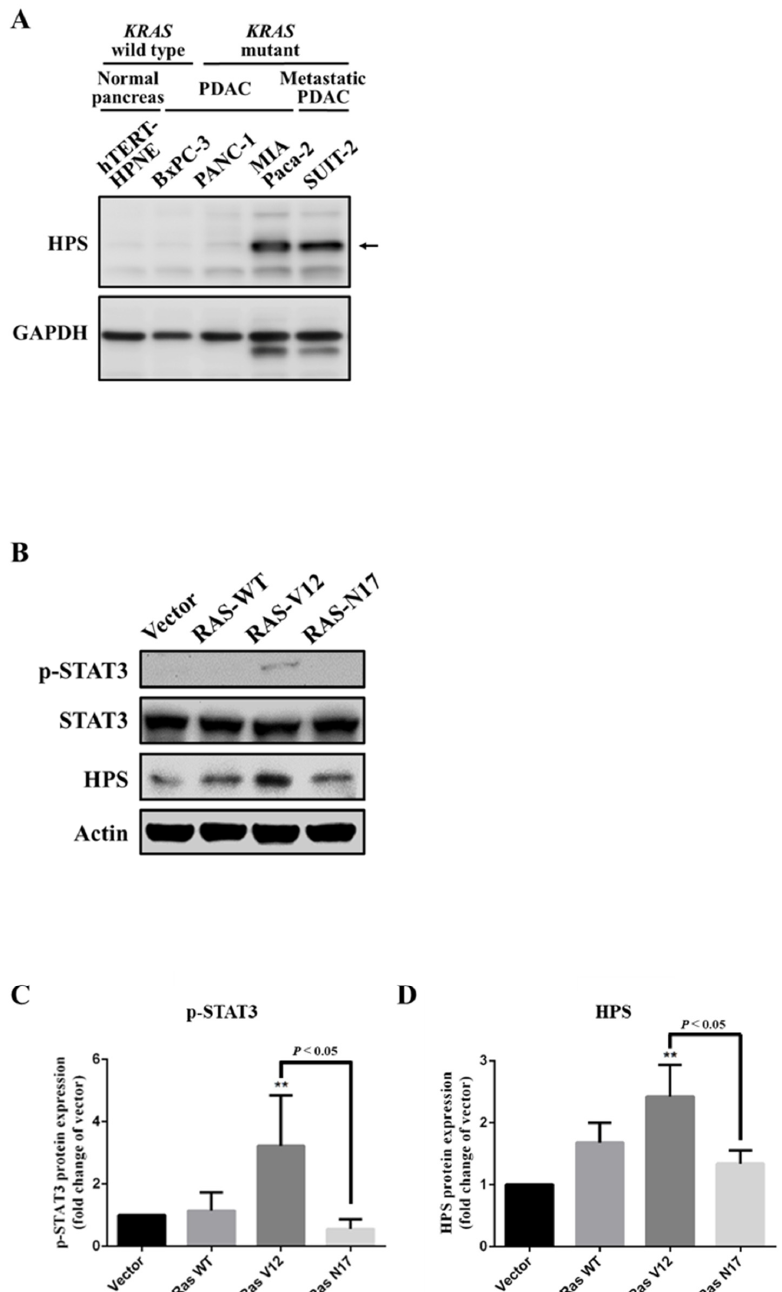
Figure 1. Expression level of hepassocin (HPS) in Kirsten rat sarcoma viral oncogene homolog (KRAS) -mutant pancreatic cancer cells. ( A ) Protein expressions of HPS and glyceraldehyde-3-phosphate dehydrogenase (GAPDH) by hTERT-HPNE, BxPC-3, PANC-1, MIA Paca-2, and SUIT-2 cells were measured by a Western blot analysis. GAPDH was used as the internal control. ( B ) Protein expressions of phosphorylated (p)-STAT3, STAT3, and HPS by HEK293T cells transiently transfected with the RAS wild-type (WT), constitutively active RAS (V12), and dominant negative RAS (N17) plasmids and a control vector were measured by a Western blot analysis. Actin was used as the internal control. The p-STAT3/STAT3 ratio ( C ) and HPS ( D ) expression level of indicated cells were analyzed with ImageJ software, normalized to actin, and evaluated as multiples of change compared to vector-transfected cells. Results are shown as the mean ± SD of three independent experiments. ** p < 0.01 by a one-way ANOVA followed by Tukey’s post-hoc